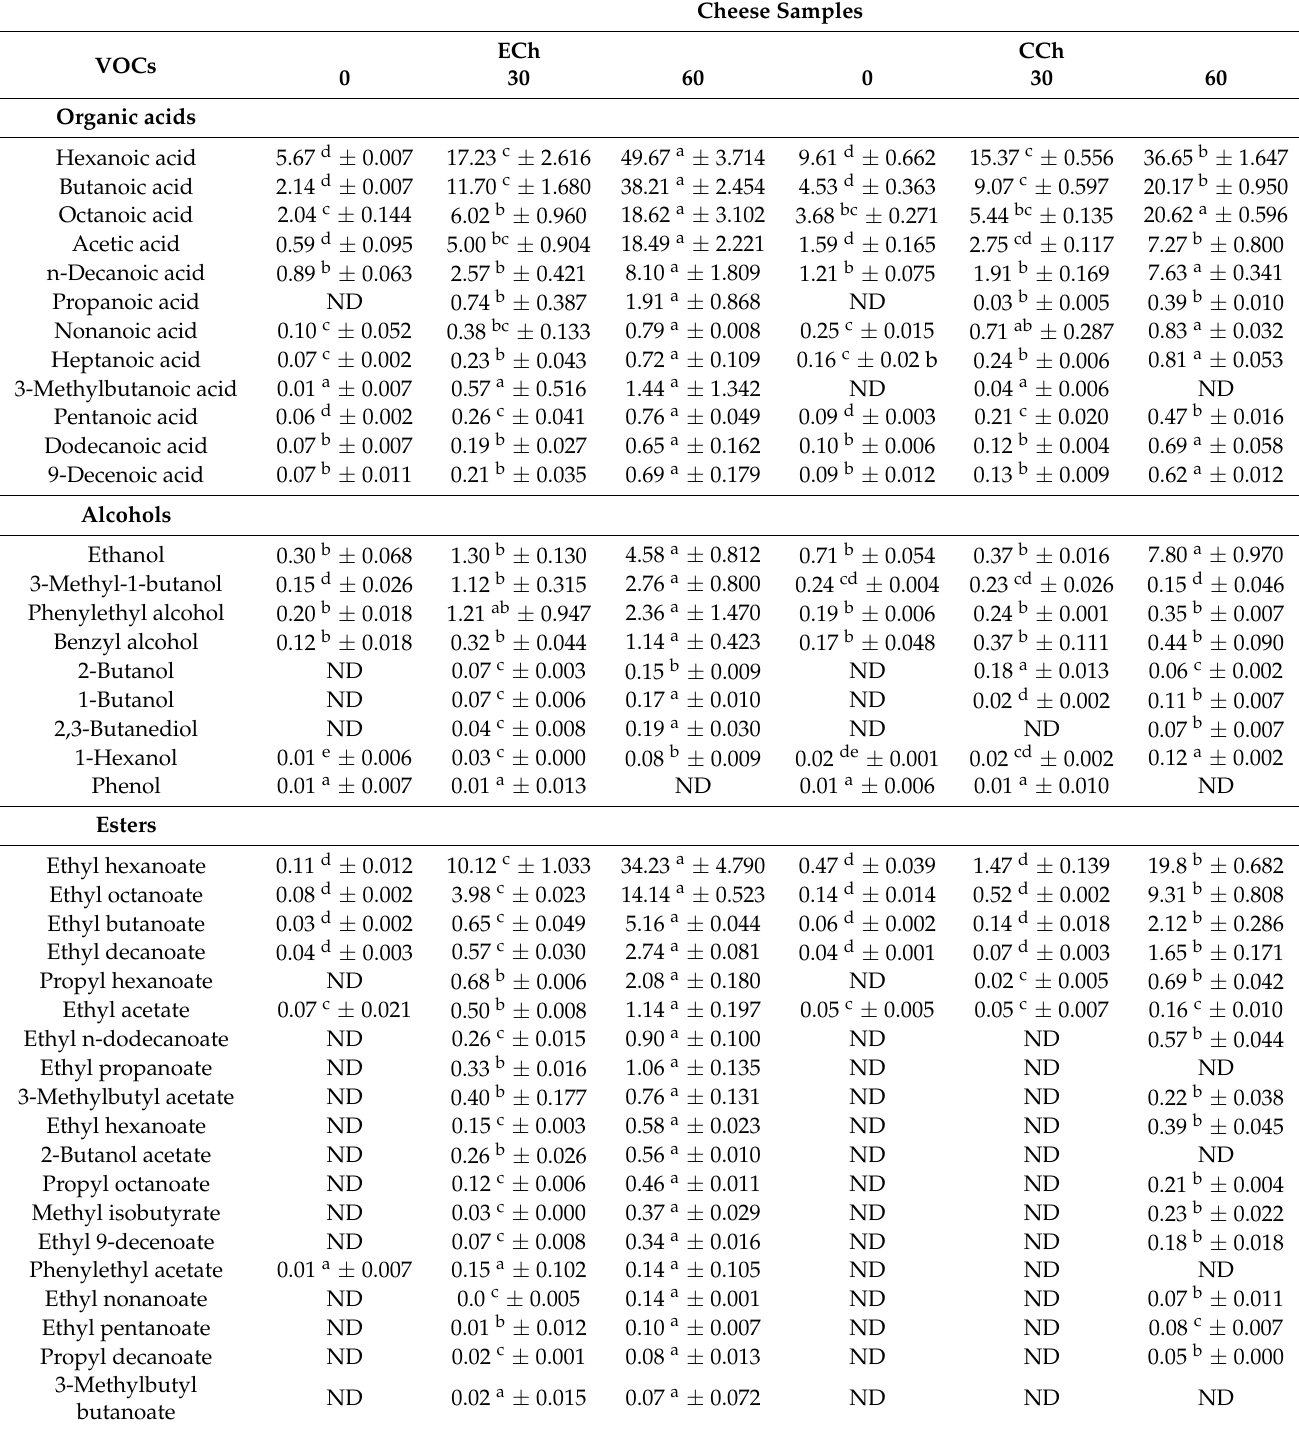
Table 6. Volatile organic compounds (VOCs) (mg/kg) identified in experimental (ECh) and control (CCh) cheeses at 0, 30 and 60 days of ripening. Data are the means and standard deviations of three independent experiments analysed in